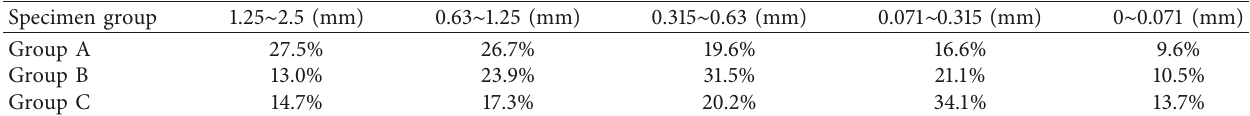
Table 2: Particle size distribution in three types of frozen